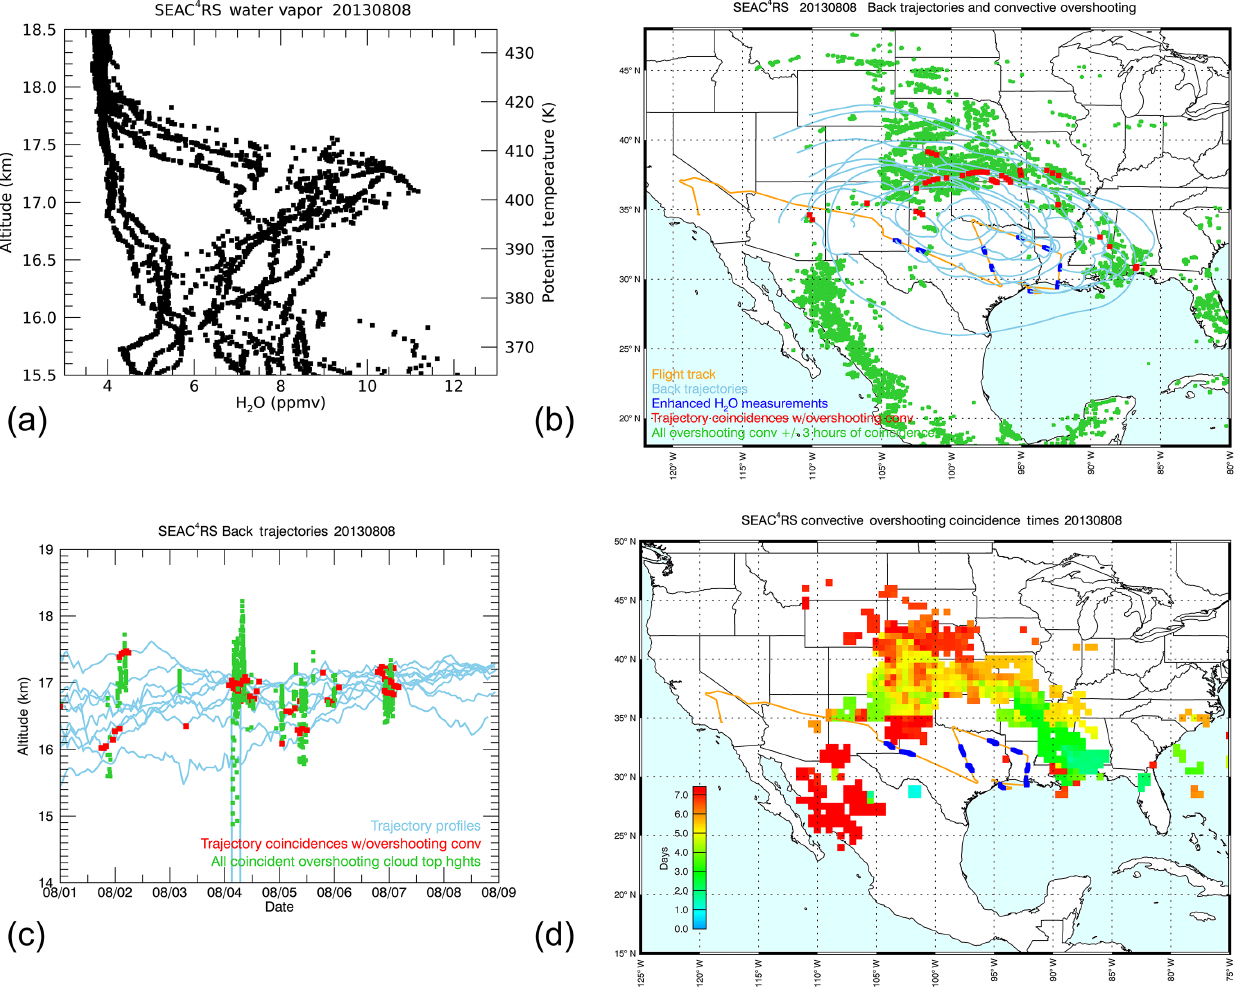
Figure 6. An analysis of the 8 August 2013 NASA ER-2 aircraft flight. (a) Vertical profiles of JLH Mark2 in situ H 2 O. Back trajectories were initialized from all aircraft water measurements at 16 to 17.5km of altitude. (b) Example back trajectories (thin blue traces) and coincident overshooting convection (red). Along the NASA ER-2 flight track (orange line), enhanced water vapor was measured (thick blue lines). This figure identifies where trajectories and OT are coincident (red squares) within the tolerances prescribed in Sect. 3.2. The green markers are overshooting convective tops within ± 3h of the red squares to indicate the main regions of convective overshooting during the 7 days prior to the ER-2 flight and which of those regions appeared to contribute most to the water vapor enhancement measured on the flight. (c) Altitude plot of example back trajectories showing coincident overshooting (red squares). The green markers are overshooting convective tops within ± 3h of the red squares. The high resolution of the convective overshooting data meant that there could be multiple coincident convective overshooting cells for a single location on a back trajectory. (d) Days between OT and intercept by the aircraft on 8 August